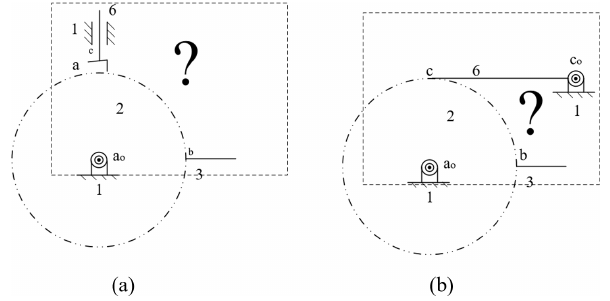
Figure 7. The waterwheel steelyard clepsydra device – model I.